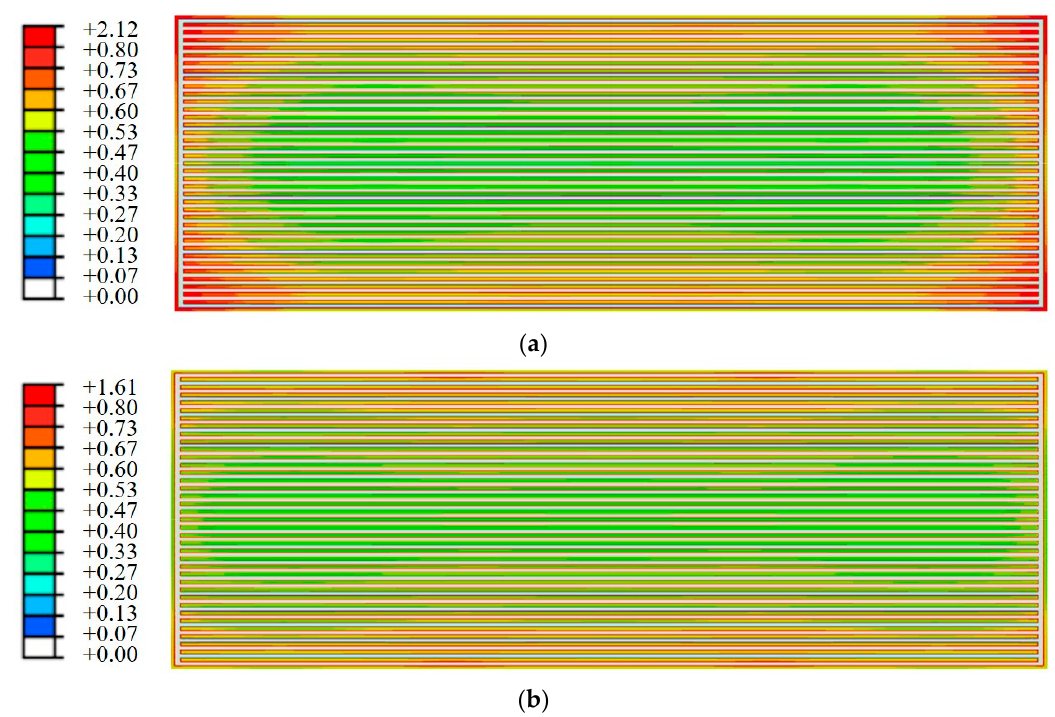
Figure 14. Comparison of contact pressure distributions of ( a ) original and ( b ) optimized designs.